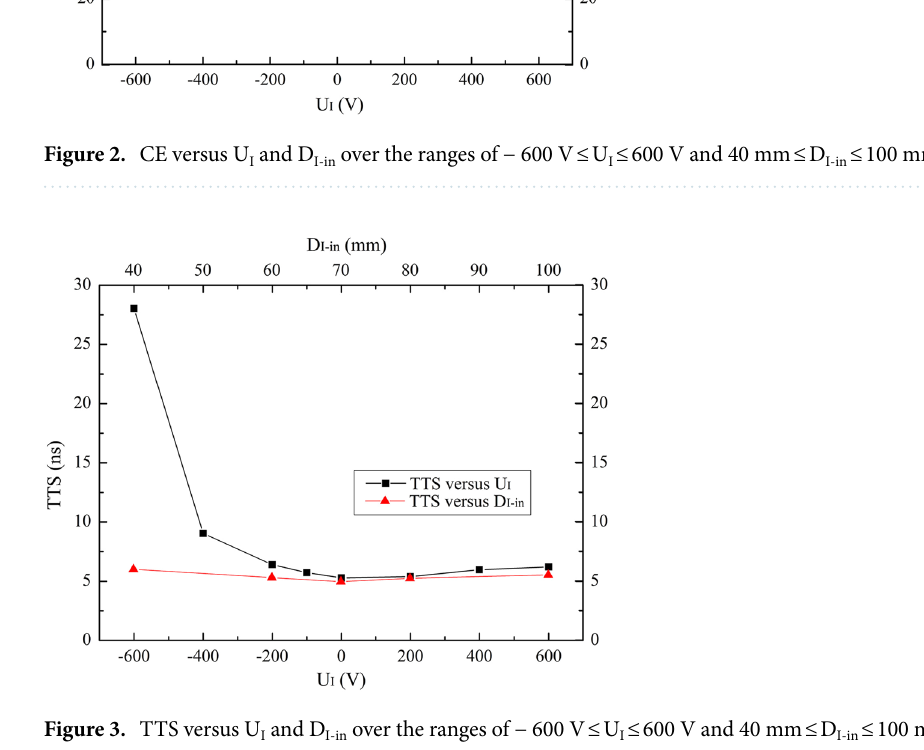
Figure 3. TTS versus U I and D I-in over the ranges of − 600 V ≤ U I ≤ 600 V and 40 mm ≤ D I-in ≤ 100